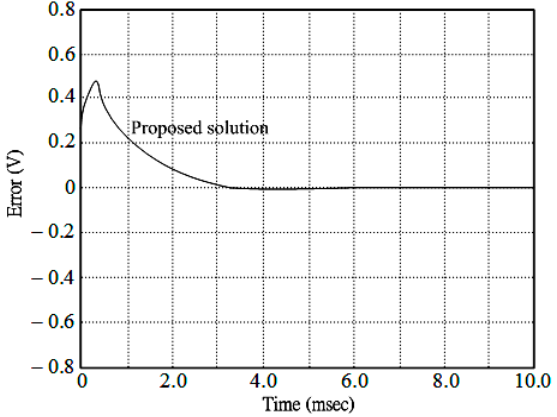
Figure 14. Convergent speed of tracking error for the proposed solution.